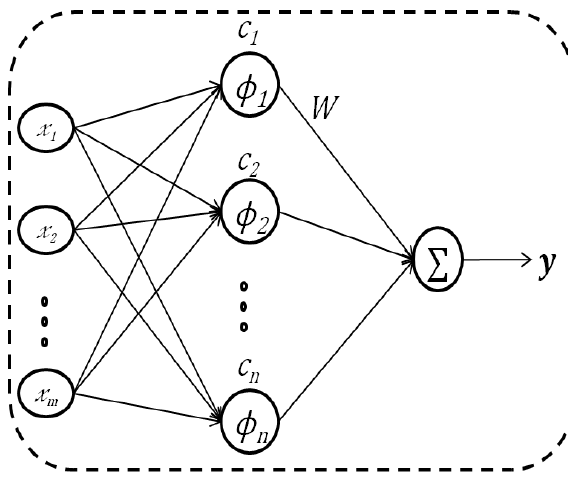
Figure 2 . Radial basis functional neural